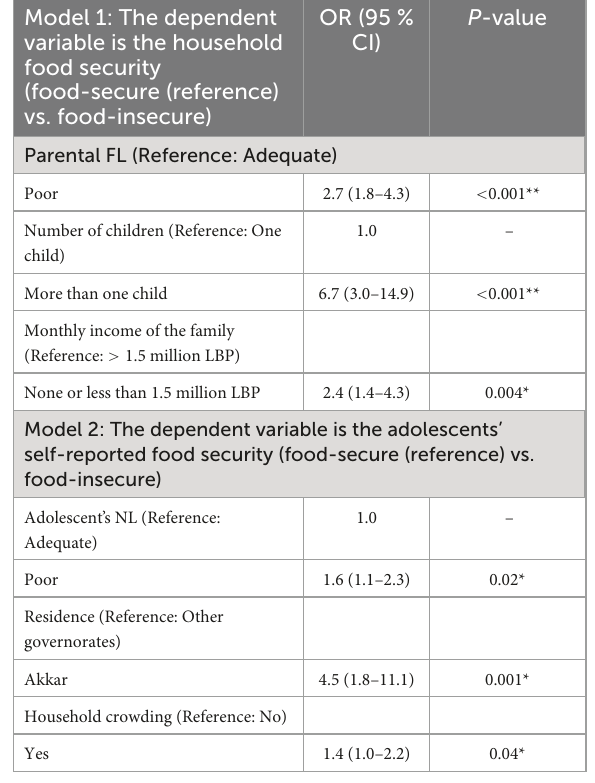
TABLE 4 The contribution of the adolescents’ NL and parental FL to predicting the household and adolescents’ self-reported FI and adolescents’ nutrition